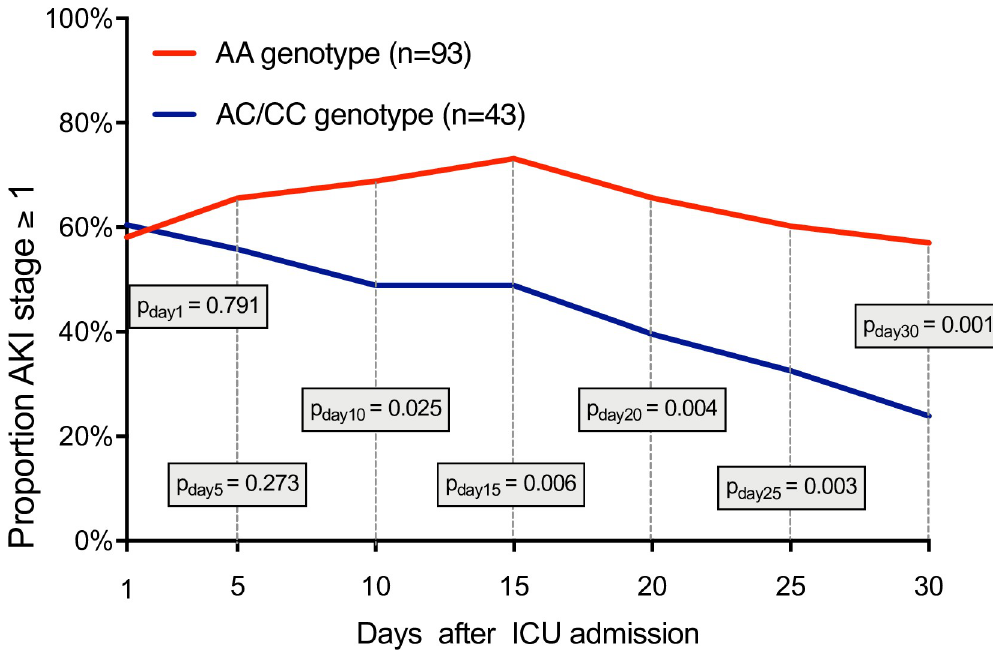
Fig 1. Proportion of all patients (n = 136) with acute kidney injury (AKI stage � 1 according to KDIGO criteria) in AA und AC/CC genotypes of the AQP5 -1364A/C promoter SNP. Measurements on day 1, 5, 10, 15, 20, 25 and 30.